Question: Describe this figure in one sentence.
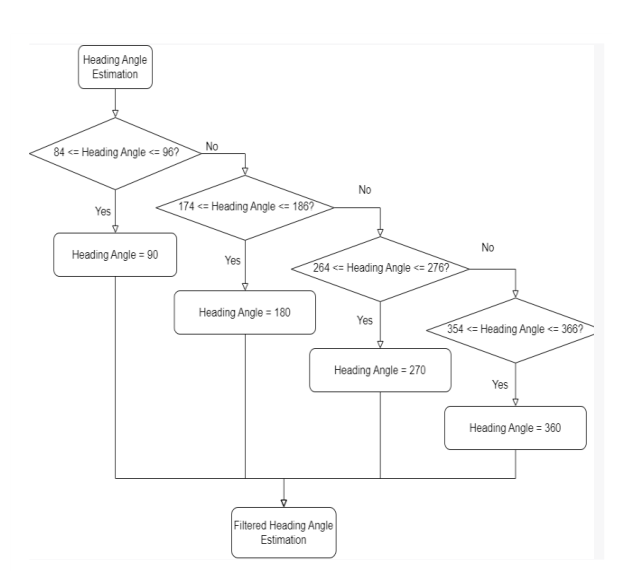
Answer: Filtering process for the heading angle estimated based on the  sensor reading.